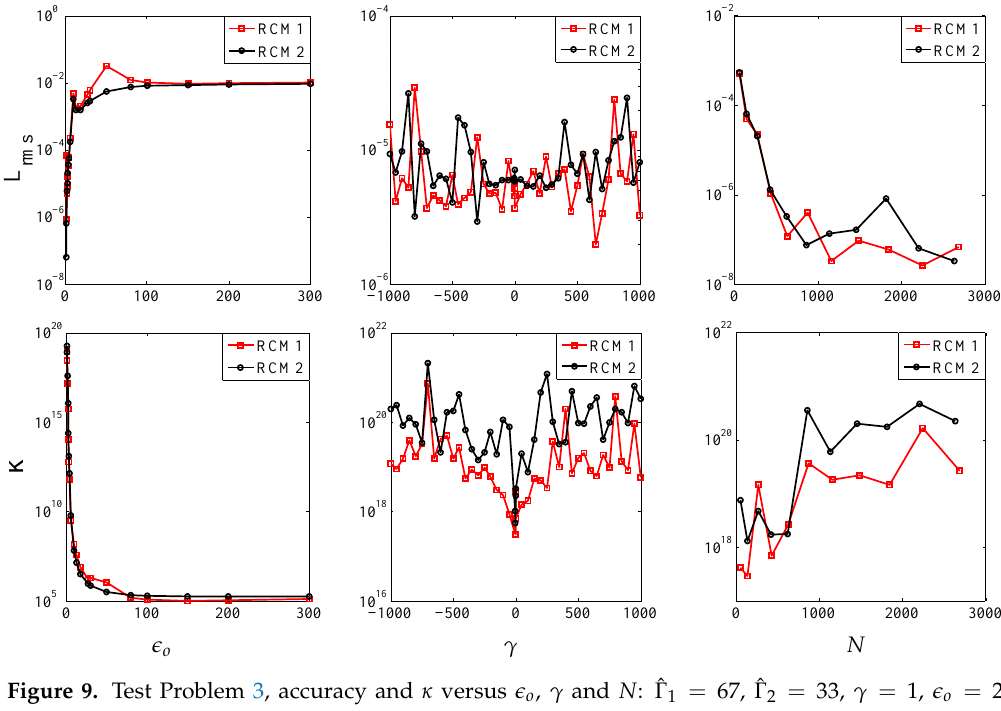
Figure 9. Test Problem 3, accuracy and κ versus (cid:101) o , γ and N : ˆ Γ 1 = 67, ˆ Γ 2 = 33, γ = 1, (cid:101) o = 2, and N = 312 when its influence is interestless.